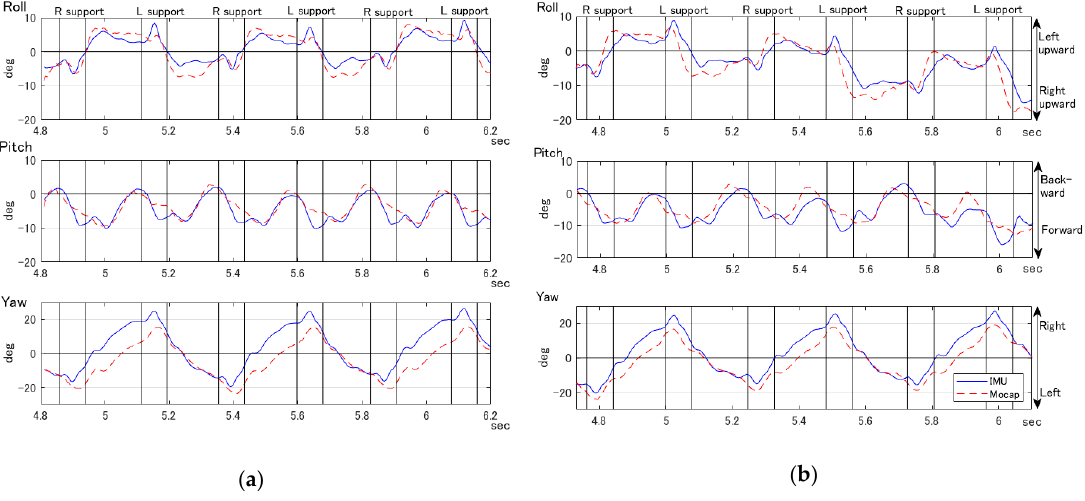
Figure 2. Representative sample of pelvic tilts of a sprinter measured with an IMU (blue line) and mocap (red dotted line) during straight sprinting ( a ) and entering the bend section ( b